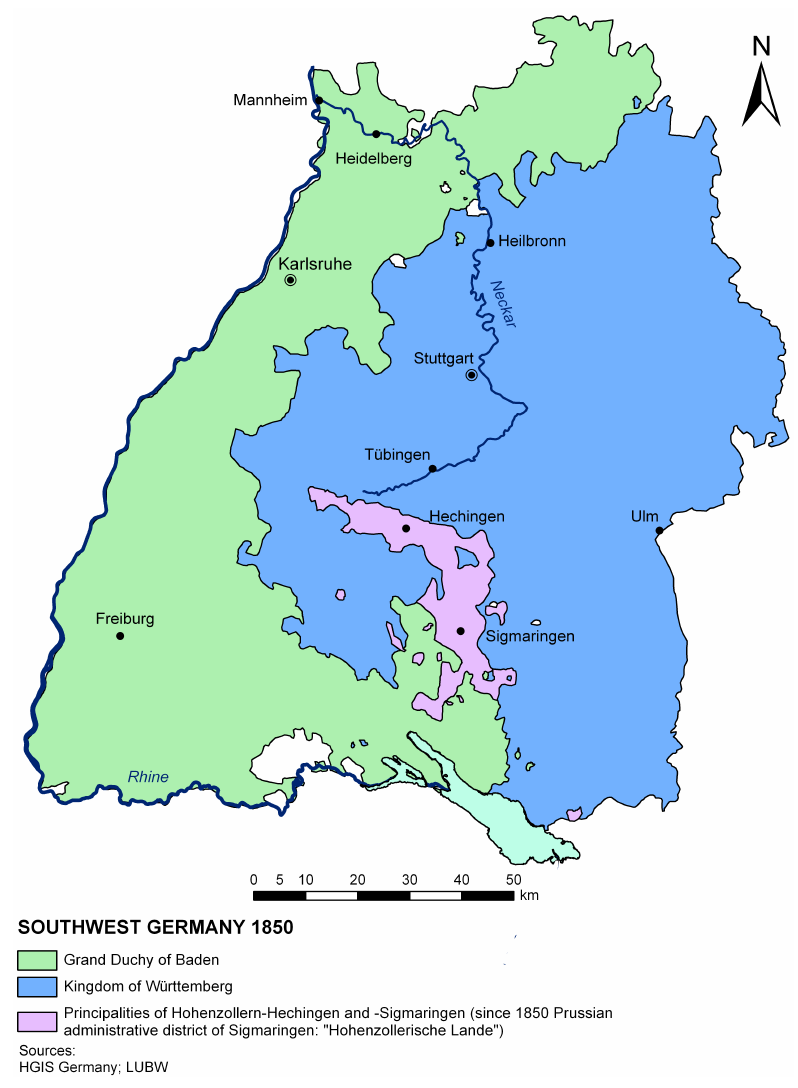
Figure 1. Study area including the historical